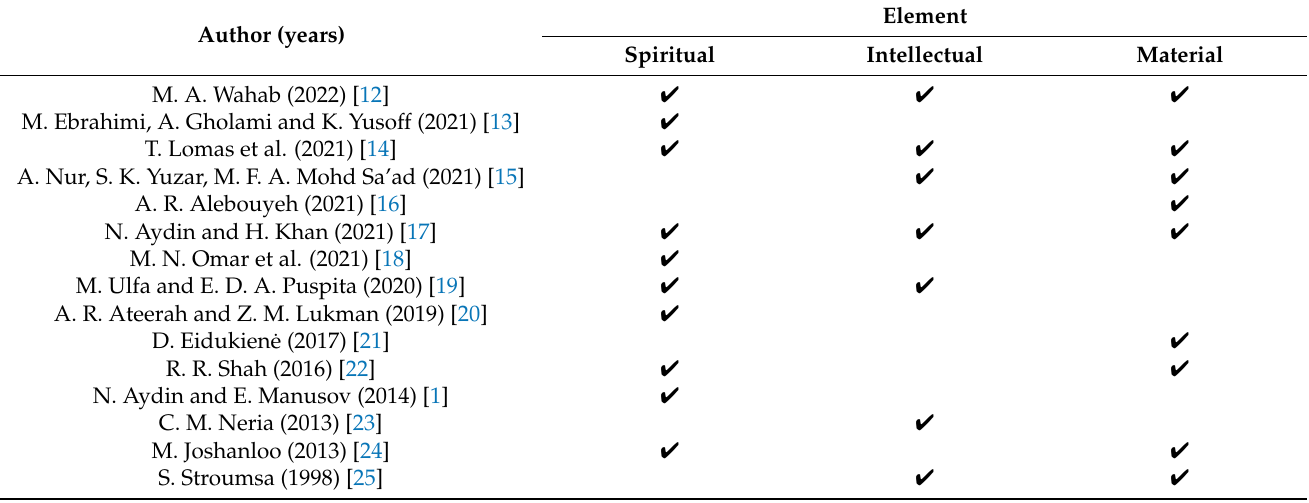
Table 5. Elements of happiness in the context of scholarly debate presented by the selected authors. Element Author (years) Spiritual Intellectual